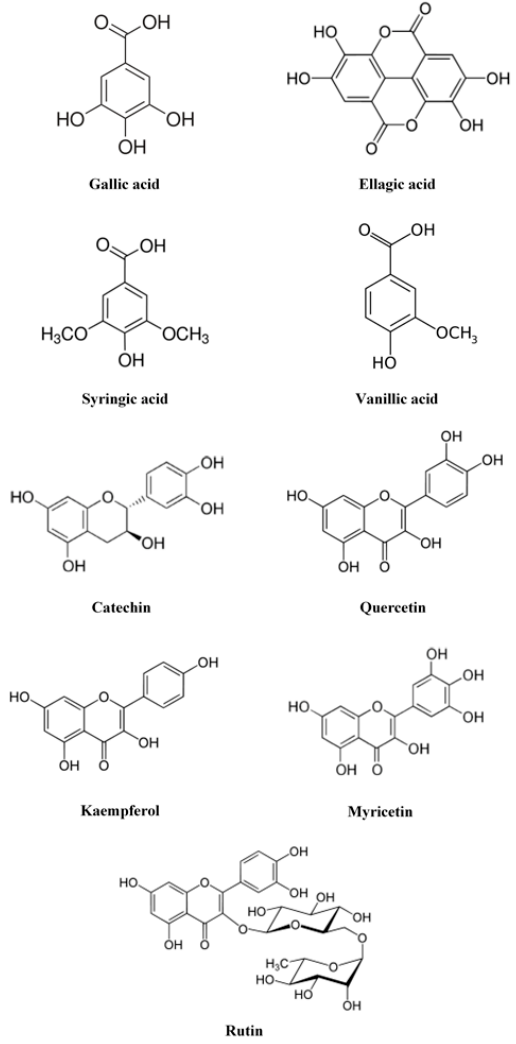
Figure 1. Chemical formulas of hydrosoluble phenolic compounds of rose hips.